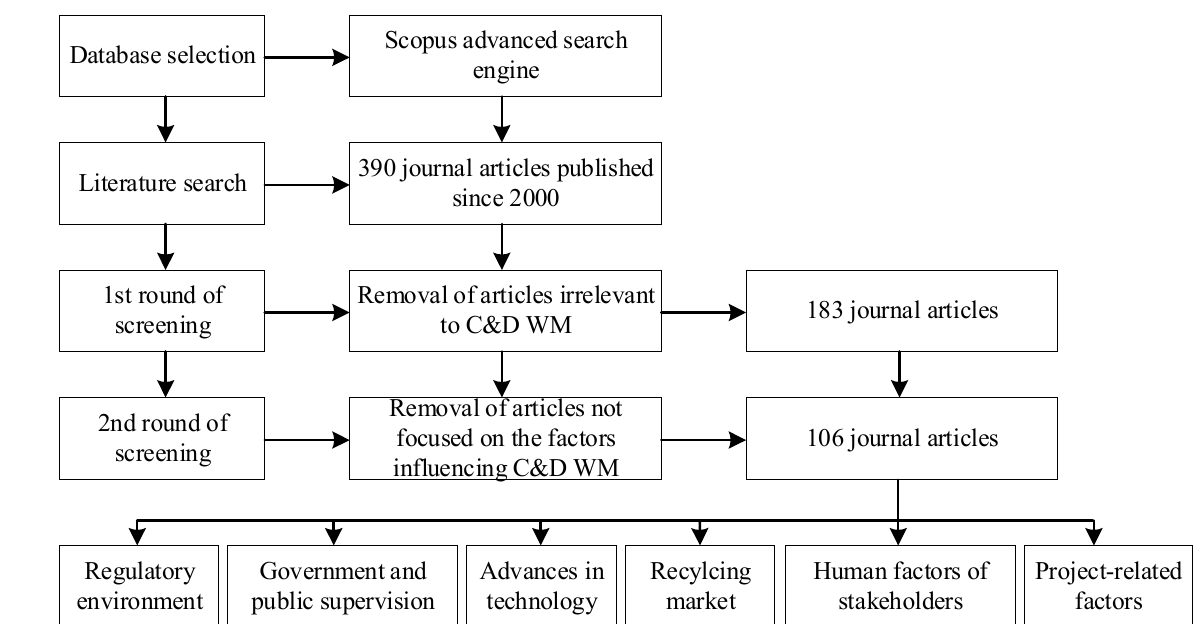
Figure 1. The review process.